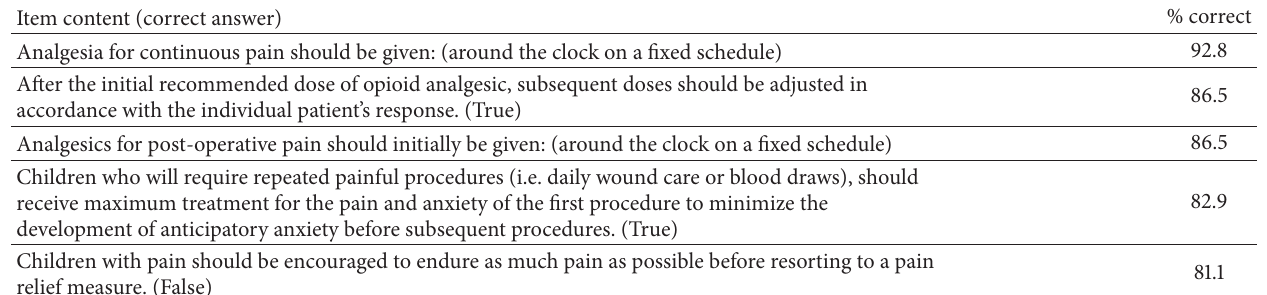
Table 2: Top 5 questions answered correctly by hospital nurses.